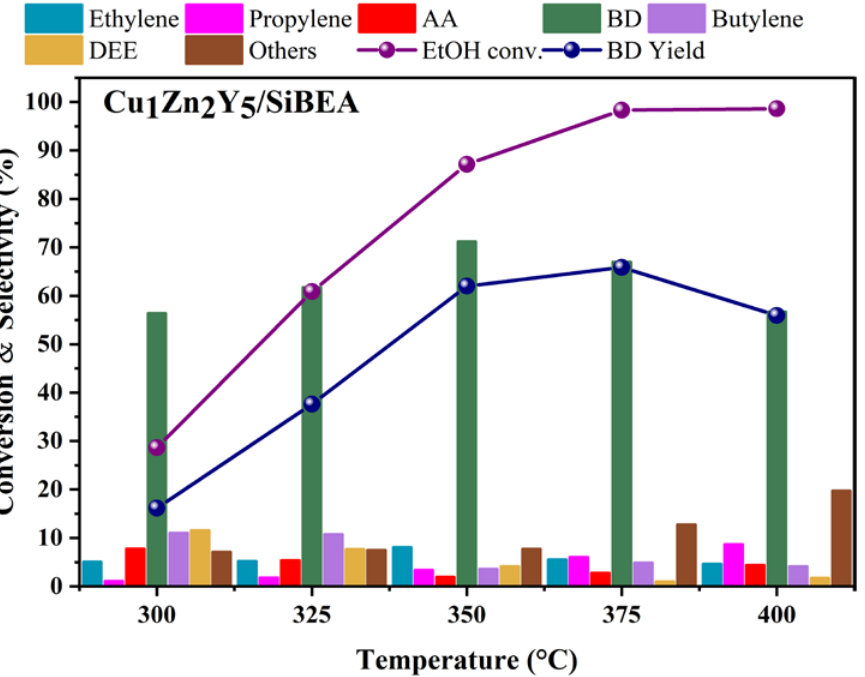
Figure 9. Effect of temperature on catalytic activities over the Cu 1 Zn 2 Y 5 /SiBEA catalyst. ETB reaction conditions: WHSV = 1·h −1 ; TOS of 8 h. Table 6. Effect of WHSV on catalytic activities over the Cu 1 Zn 2 Y 5 /SiBEA